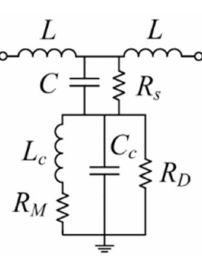
Figure 2. Lumped element equivalent circuit of the CSRR-loaded embedded microstrip line, without liquid in the container.